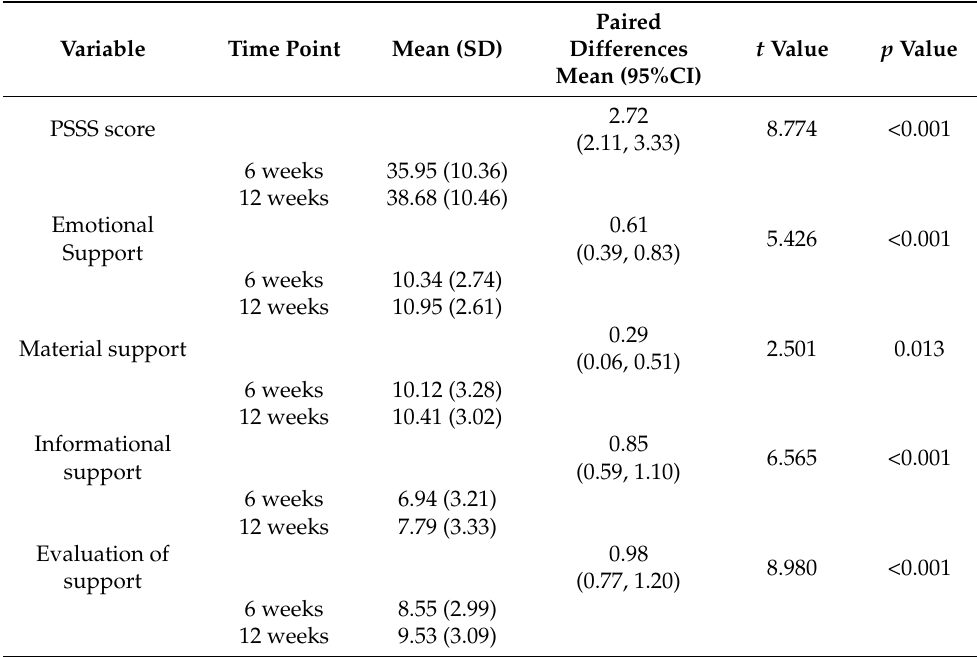
Table 8. Comparison of PSSS score and scores of its four dimensions at 6 and 12 weeks postpartum ( n =